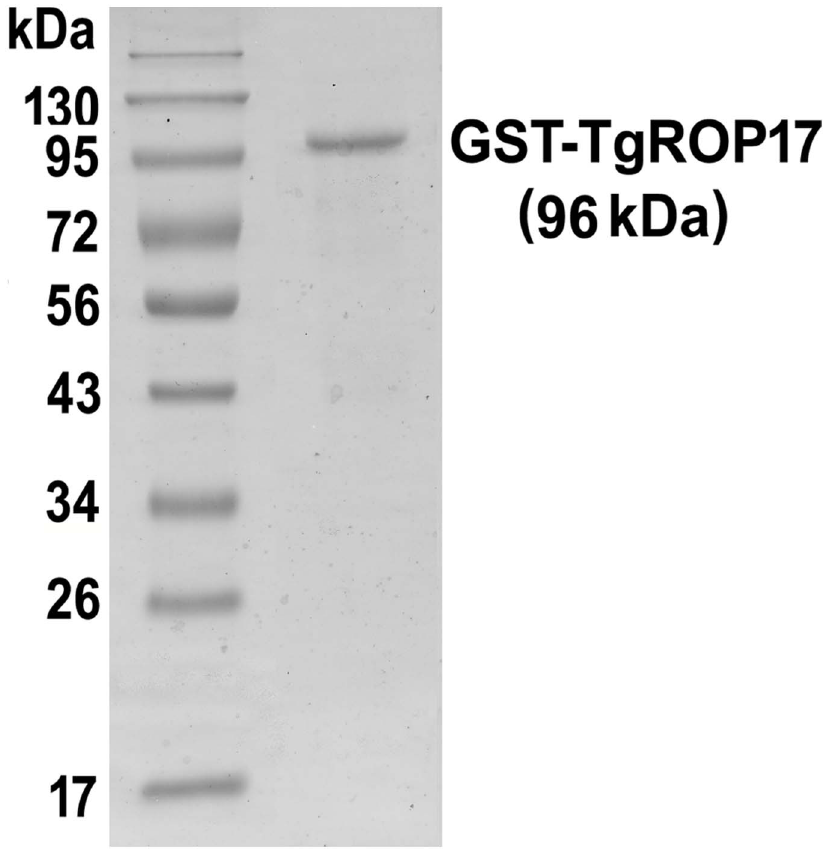
Figure 1. SDS-PAGE analysis of the rTgROP17 protein. Purified rTgROP17 protein was analysed by 12% SDS-PAGE and Coomassie blue staining. The purity of the rTgROP17 was greater than 95%.